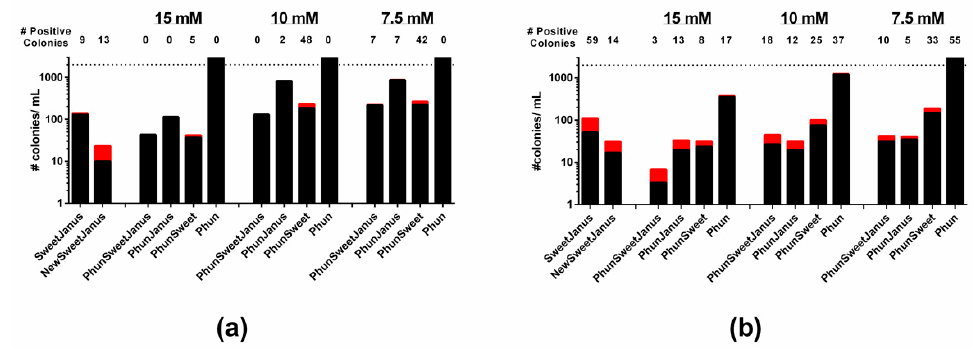
Figure 5. Novel cassettes are effective for allelic replacement of capsule. Cassettes (below column) replaced the capsule loci in ( a ) TIGR4/TIGR4S and ( b ) D39/D39S. The acaspular mutants were transformed with D39 genomic DNA and transformants were selected on counter-selection agents listed in Table 5, with the concentration of chlorinated phenylamine ranging from 7.5 mM to 15 mM. The number of true-positive colonies (red bars, number above column) and the number of false-positive colonies (black bars) were determined per mL of transformation. Dashed line represents upper limit of detection.